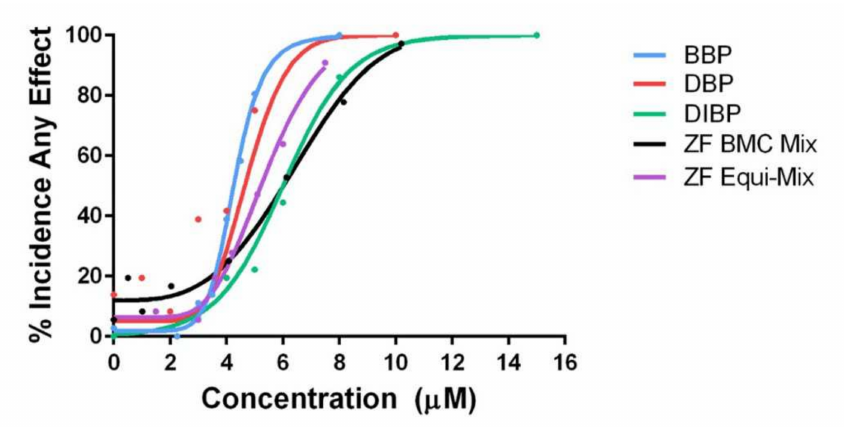
Figure 3. Concentration–response curves of bioactive phthalates and equimolar (ZF Equi-Mix) and BMC-anchored (ZF BMC Mix) mixtures in